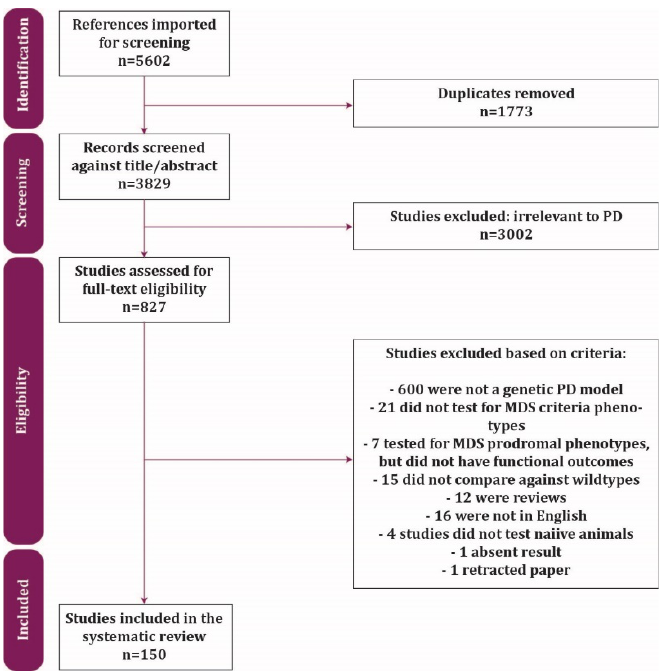
Figure 1. Flow chart following PRISMA guidelines of the selection process and reasons for exclusions.